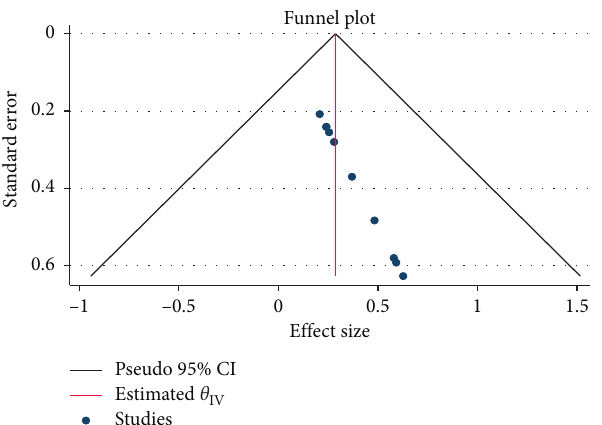
Figure 3: Funnel plot with 95% confidence limits of the pooled prevalence of Escherichia coli in under-five children with diarrhea in